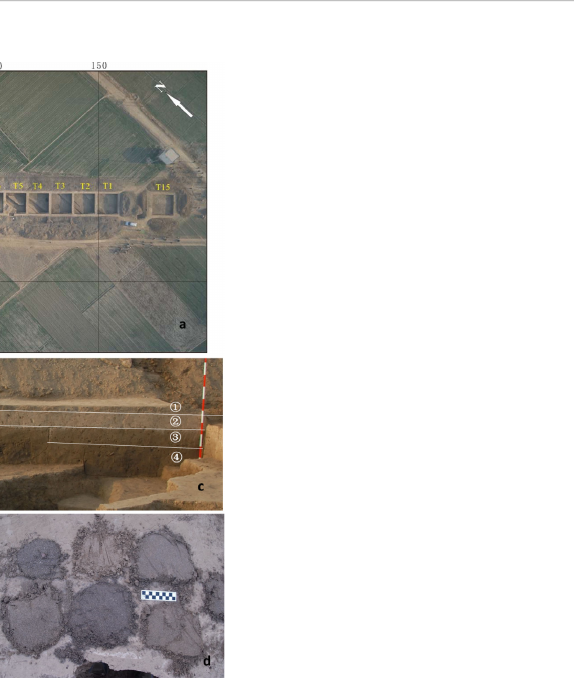
FIGURE 2 Structure and spatial distribution of the Late Quaternary deposits in the FTG site. (A) . The distribution of excavation grids in the FTG site. The lacustrine facies strata are mainly distributed in T1-T9, while T10-T14 are primarily the cultural deposits of ancient human activities; (B) The